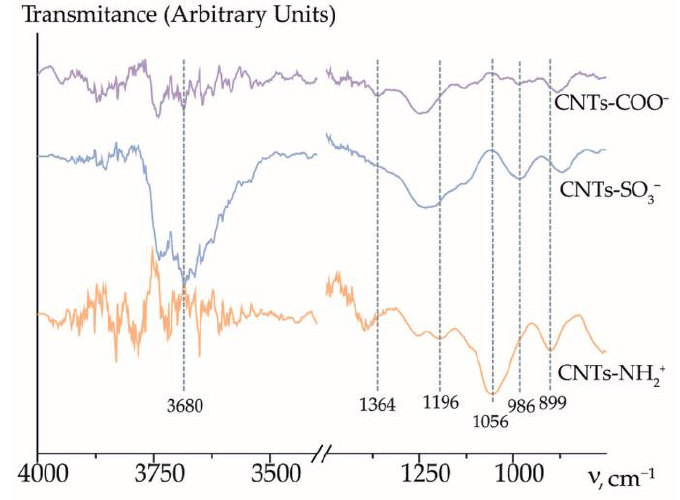
Figure 5. FTIR spectra of CNTs-COO − , CNTs-SO 3 − , and CNTs-NH 3+ .